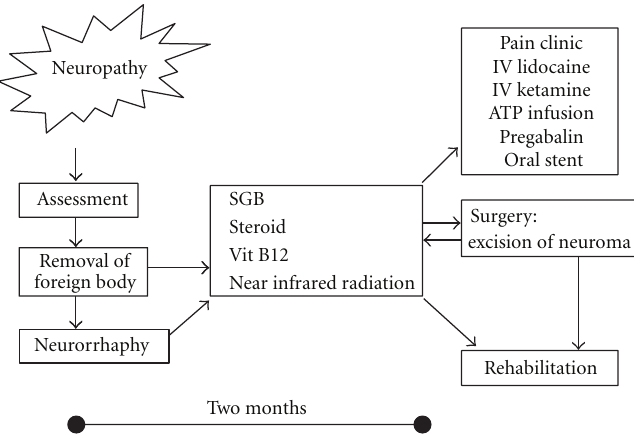
Figure 15: Therapies for neuropathy